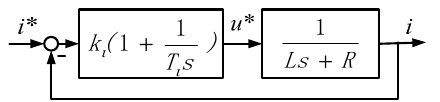
Figure 12. Transfer function block of the current regulator.